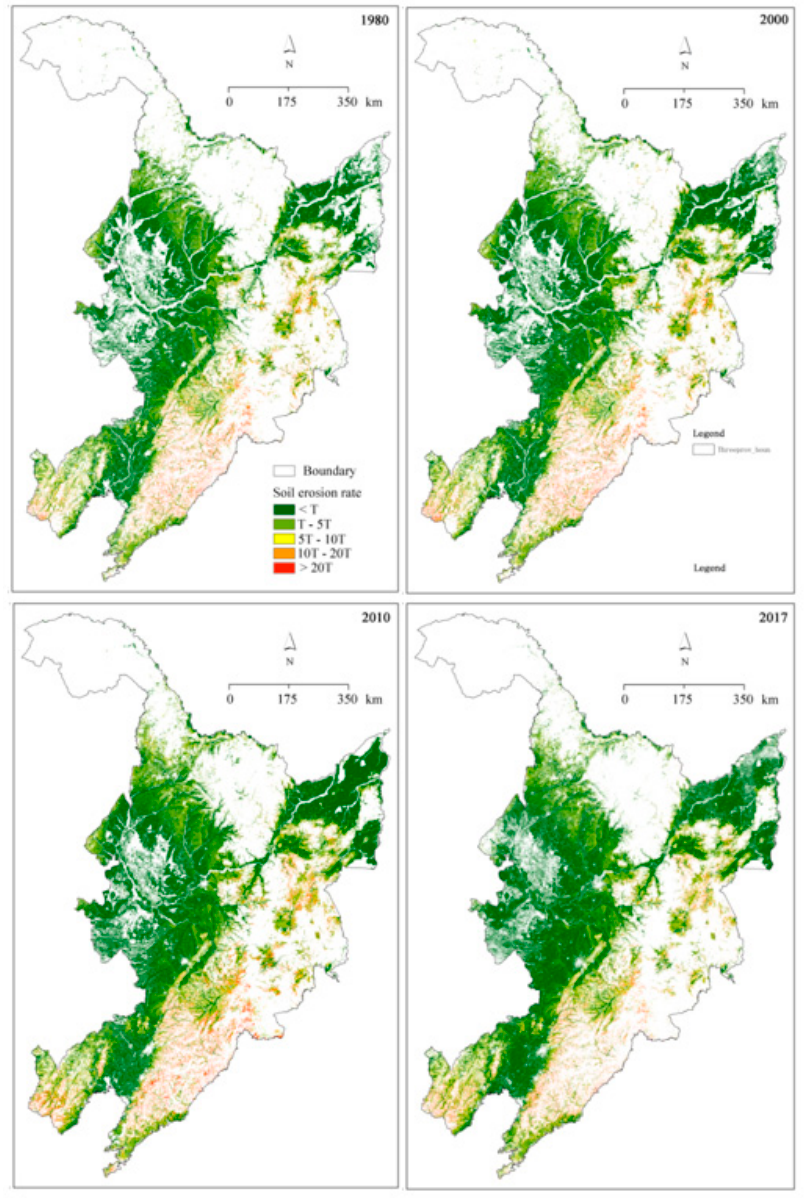
Figure 4. Spatial distributions of soil loss rate on the cultivated slopes in the years 1980, 2000, 2010, and 2017. Note: T = 200 t·km − 2 ·yr − 1 .